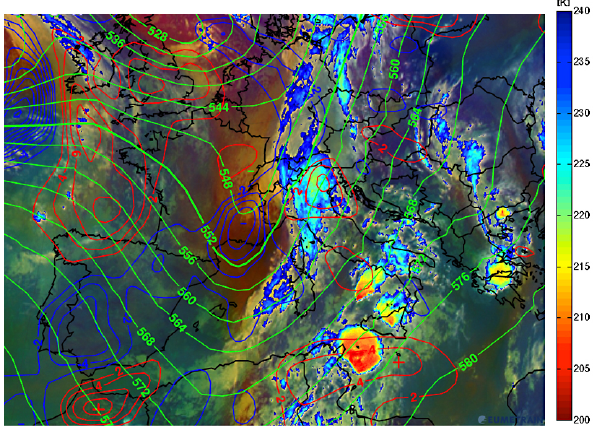
Figure 8. As in Fig. 2, but at 12:00UTC, 15 October 2012. Source: